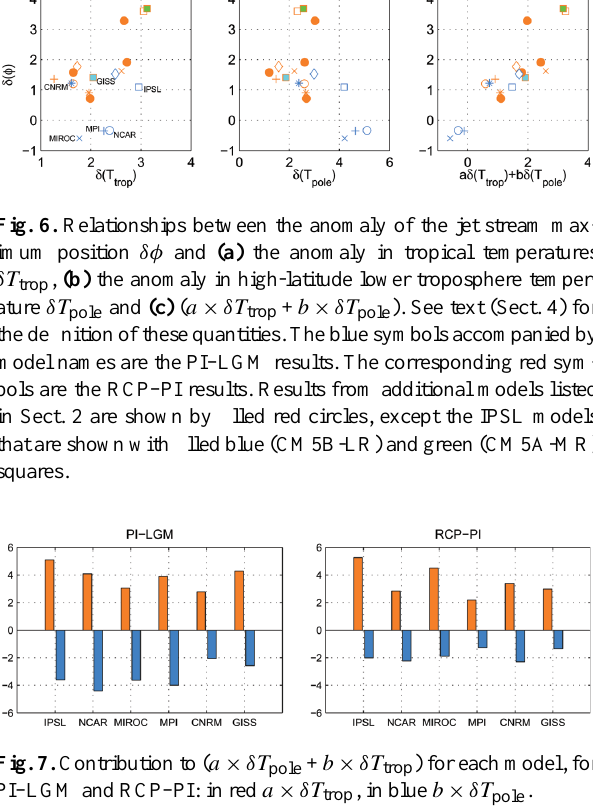
Fig. 5. Anomalies in the zonal mean temperature (in K) for the 6 models, for RCP–PI (first two rows) and PI–LGM (last two rows). Continuous lines show the mean temperature in PI.